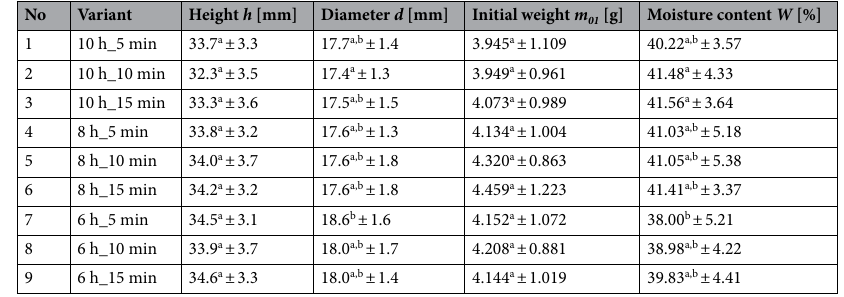
Table 3. Mean parameter values and standard deviations for the nine process variants. a, b – homogeneous groups.